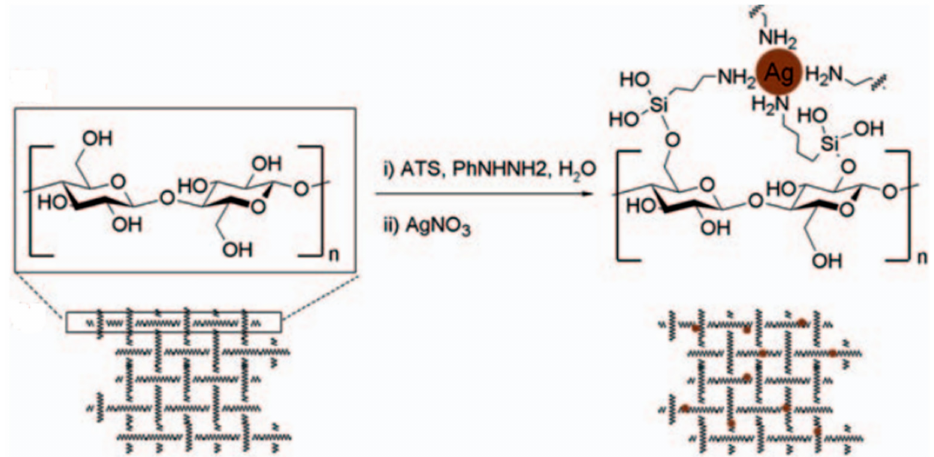
Figure 10. Schematic representation of the formation of silver nanoparticles directly in the cotton fibers. Retrieved from